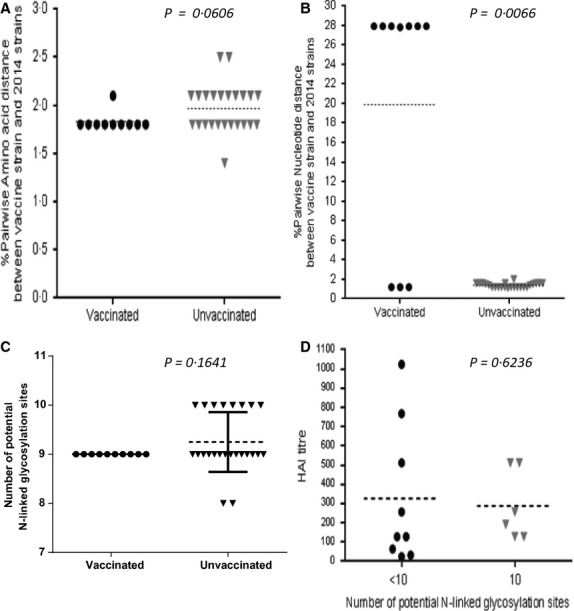
Graphic presentation of (A) pairwise amino acid distance and (B) pairwise nucleotide distance to the 2014 vaccine strain, (C) the number of potential N-linked glycosylation sites in H3N2 strains from vaccinated and unvaccinated VW participants as well as (D) determining the effect of number of N-linked glycosylation sites on antigenic relatedness to the vaccine strain using haemagglutination inhibition titres.